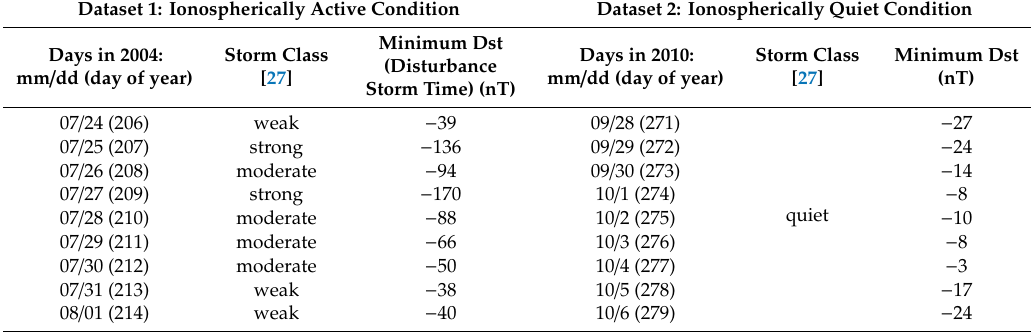
Table 1. Dataset 1: Nine days in 2004 (active ionospheric condition) and Dataset 2: Nine days in 2010 (quiet ionospheric